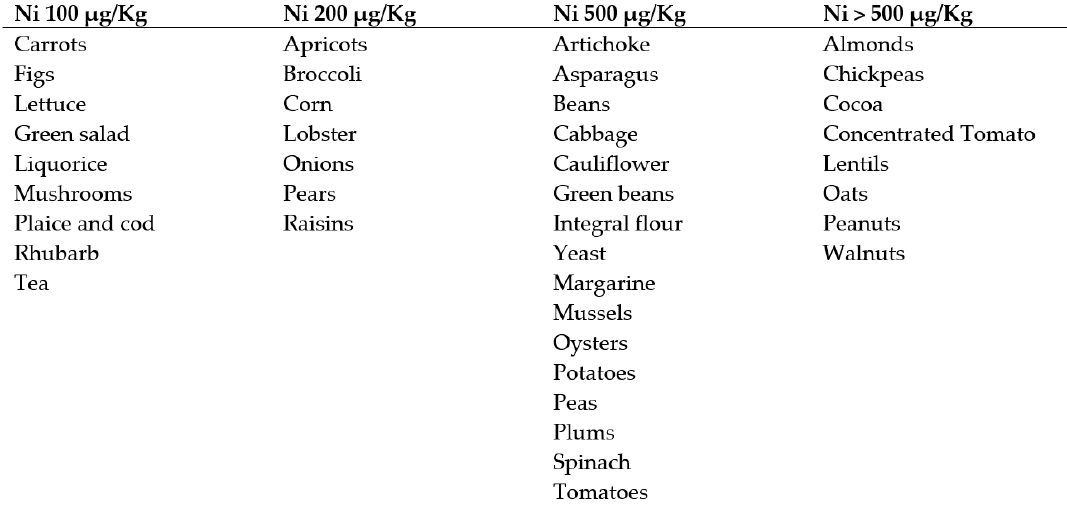
Figure 2. Average amount of Ni in different foods.